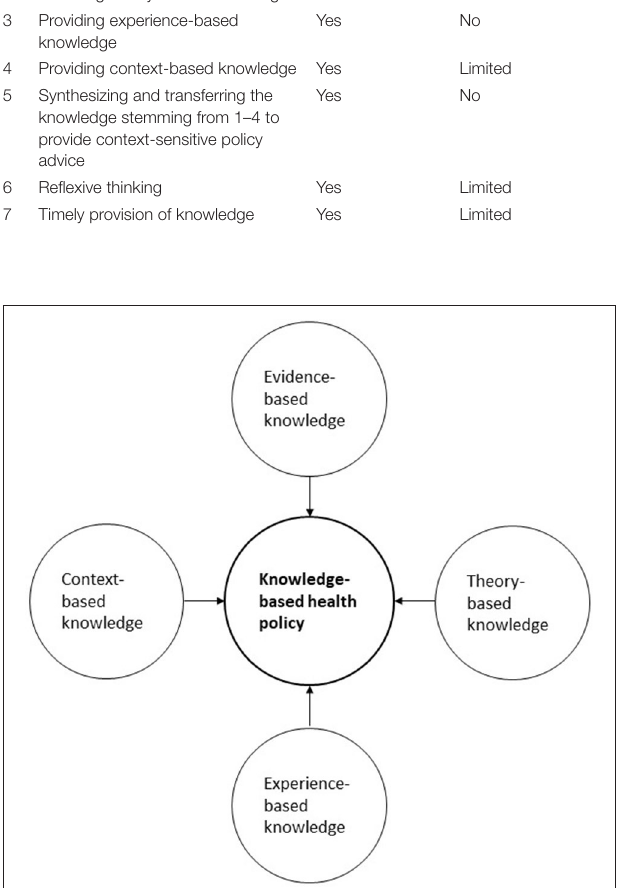
FIGURE 1 | Knowledge-based health policy: knowledge